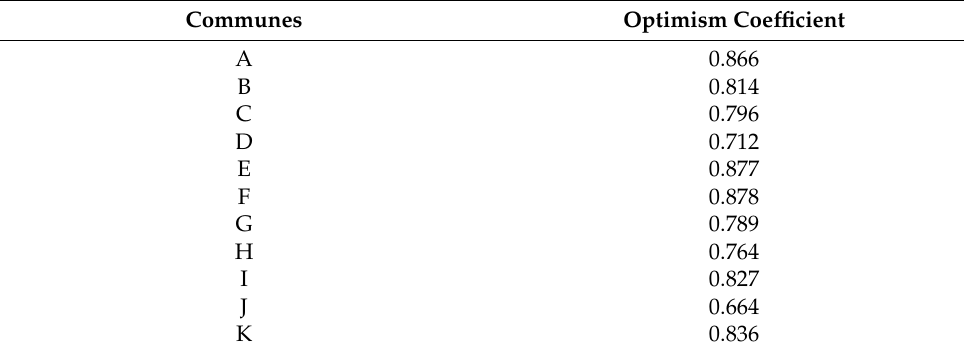
Table 4. Values of the optimism coefficient for communes.